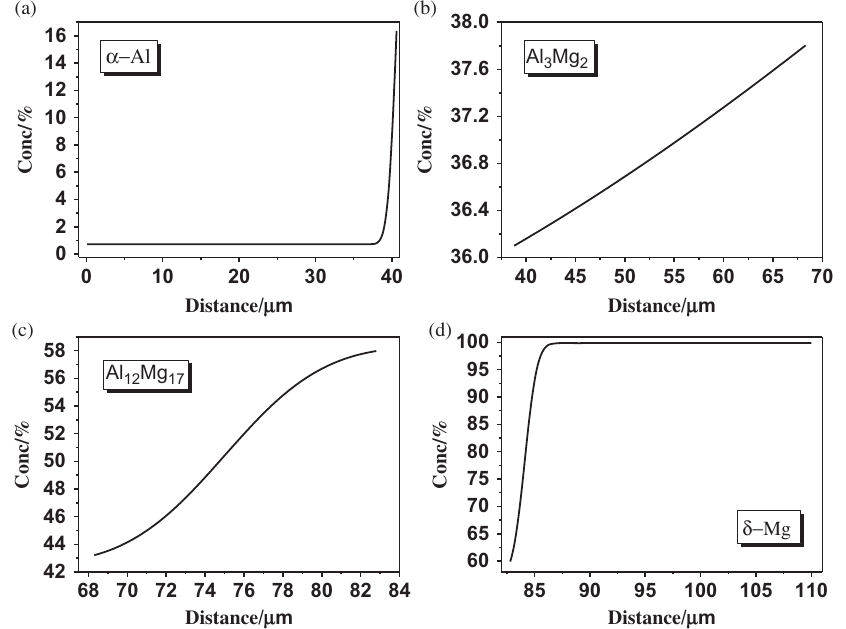
Figure 5: ConcentrationdistributionofMgineachphaseatthejointinterface(a) α -Alsolidsolution;(b)Al 3 Mg 2 ;(c)Al 12 Mg 17 ;(d) δ -Mgsolidsolution.